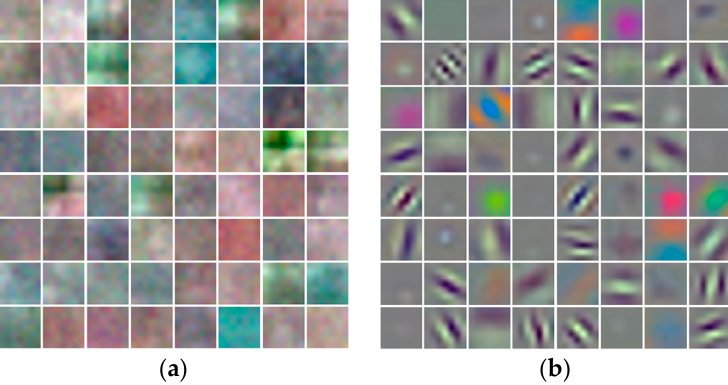
Figure 10. Visualization of learned filters from the first convolutional layer in the case of (a) training from scratch with random initialization, and (b) fine-tuning with transfer learning.